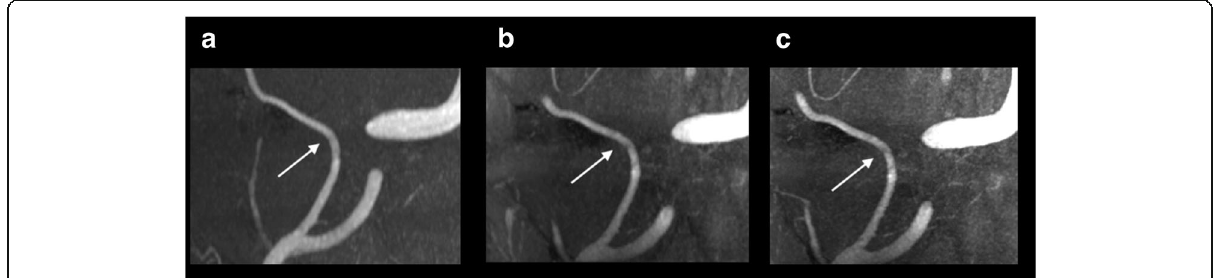
Fig. 4 Examples of the middle meningeal artery (arrow) in three different data sets. a : 3.0 T scan; b : 7.0 T scan at low resolution; c : 7.0 T scan at high resolution